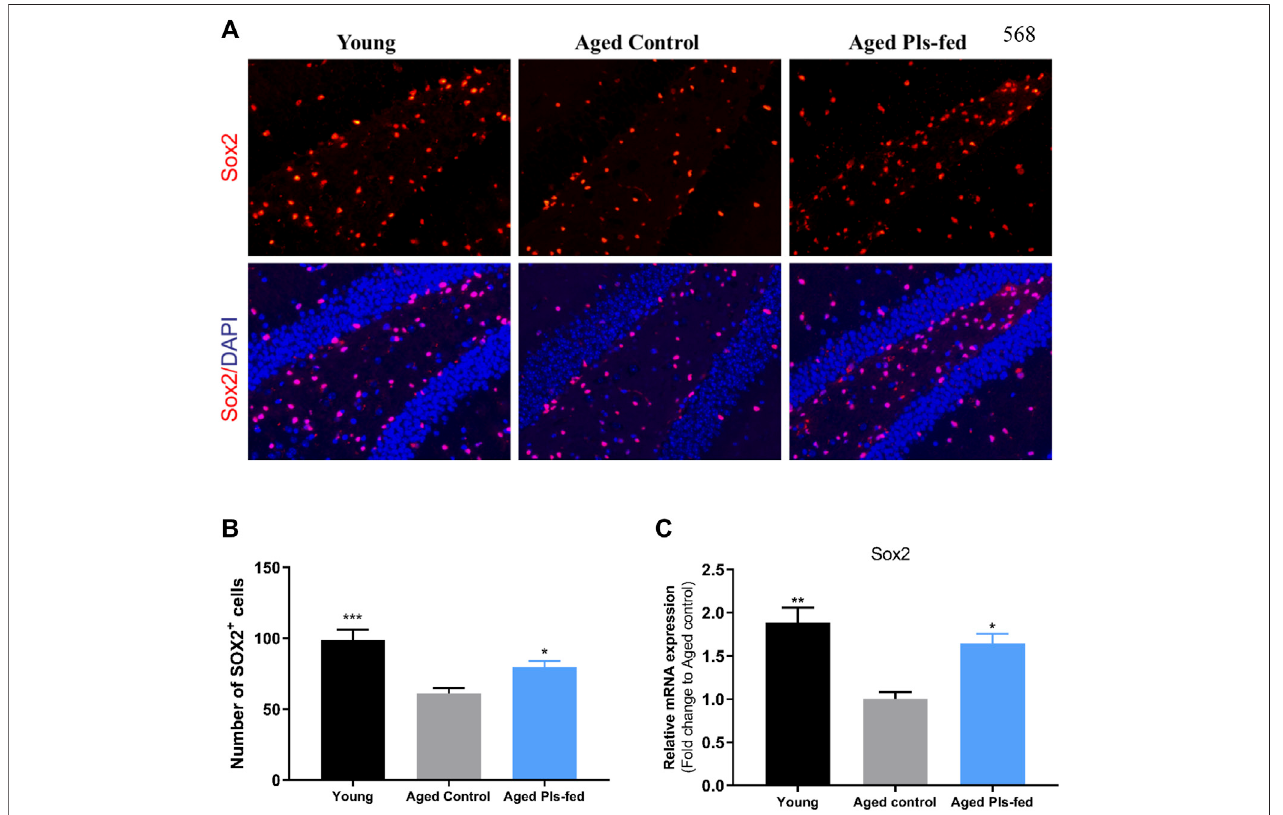
FIGURE 6 | Plasmalogens promote neurogenesis in the aged murine hippocampus. (A) Representative fl uorescence images showing neural stem cells in young control, aged control and aged Pls-fed mice of hippocampal dentate gyrus (DG). Cells are identi fi ed based on anti-Sox2 (red). DAPI indicates nuclear staining (blue). (B) graph showed quanti fi cation of Sox2+ cells among groups. (C) The real-time PCR data showed mRNA expression of Sox2 in hippocampus of young control, aged controland agedPls-fed mice.All valuesarepresented asmean±SEM.Asterisksindicatestatisticalsigni fi cances compared toAged controlbyone-way ANOVA; signi fi cance (* p < 0.05; ** p < 0.01; *** p < 0.001), scale bars, 50 μ m n = 4 mice for each